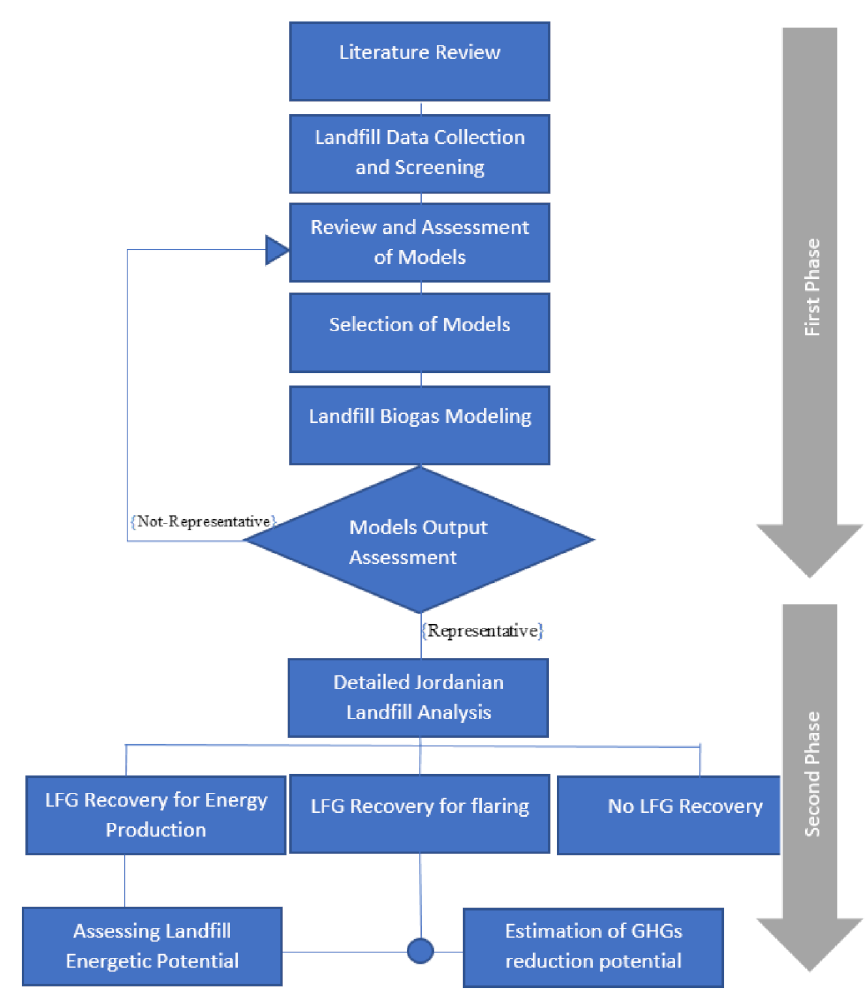
Figure 2. Flowchart shows the methodology that was followed in conducting this